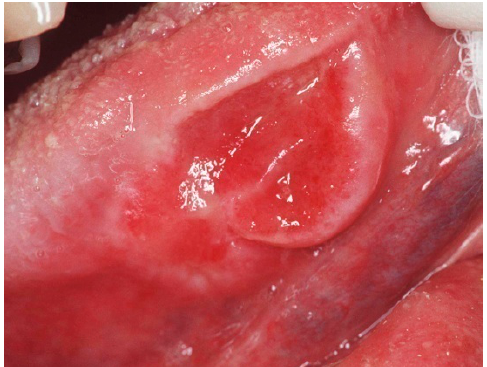
Figure 1. Ulcerative lesion of the border of the tongue: a biopsy was performed with histological examination that confirmed the suspicion of oral squamous cell carcinoma.